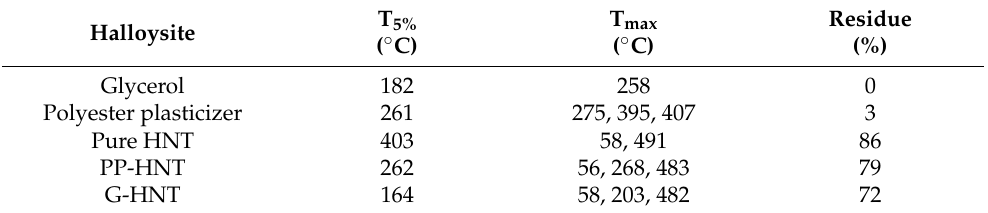
Table 2. TGA data of glycerol, polyester plasticizer, pure and modified